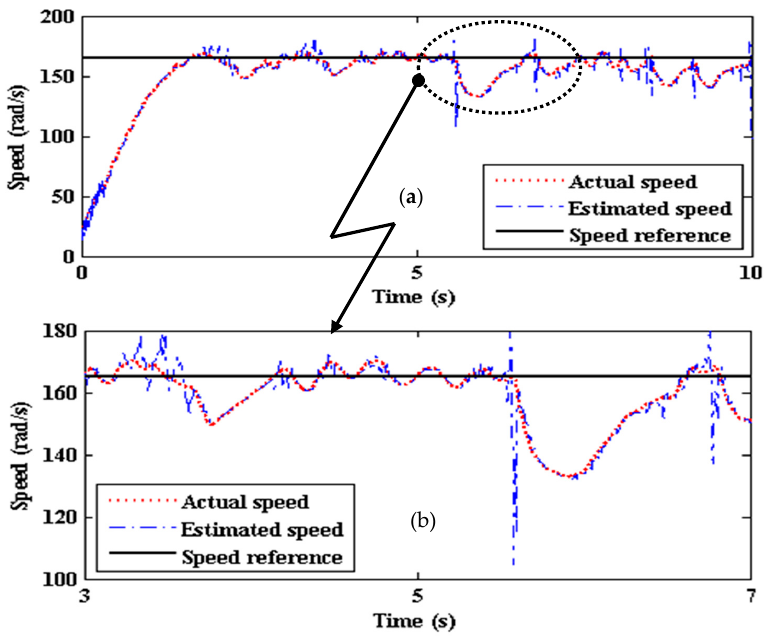
Figure 6. ( a ) Estimated speed of conventional sliding mode luenberger observer (SMLO) 1; and ( b ) zoomed version of ( a ).